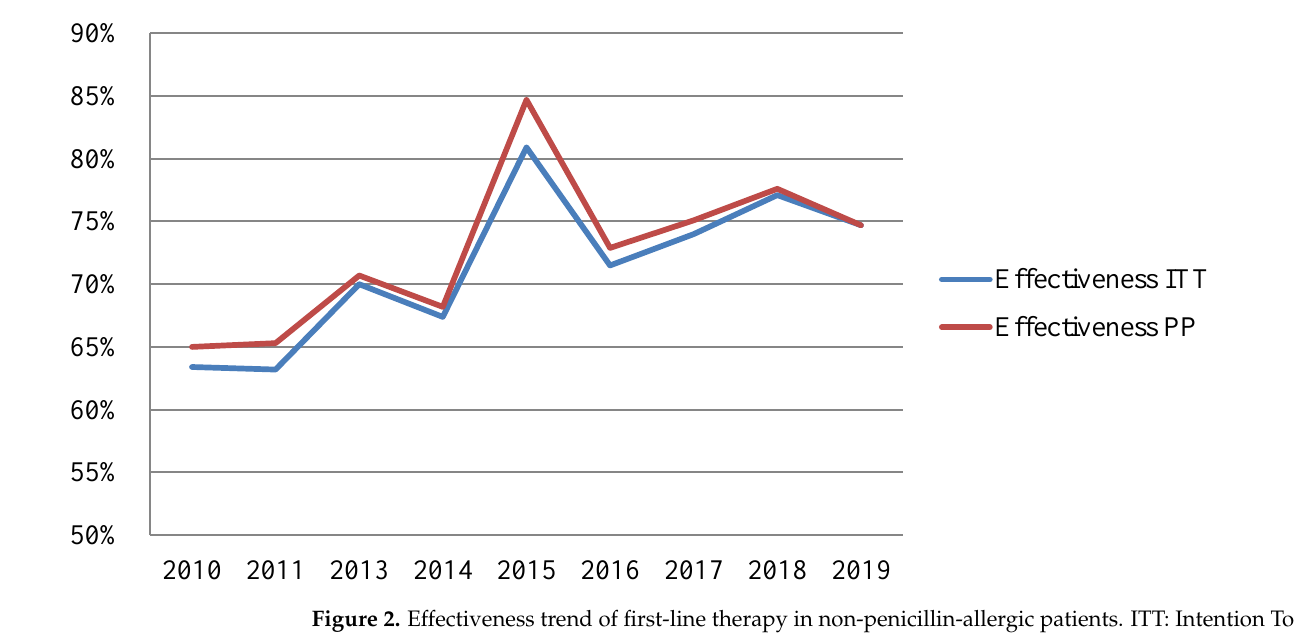
Figure 2. Effectiveness trend of first-line therapy in non-penicillin-allergic patients. ITT: Intention To Treat. PP: Per Protocol.